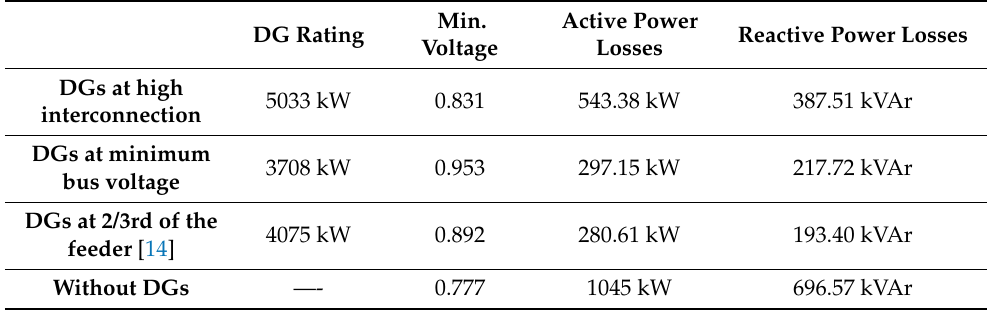
Table 8. Summary of the load flow results at 200% loading, or a total connected load of (7162 + j3490) kVA.